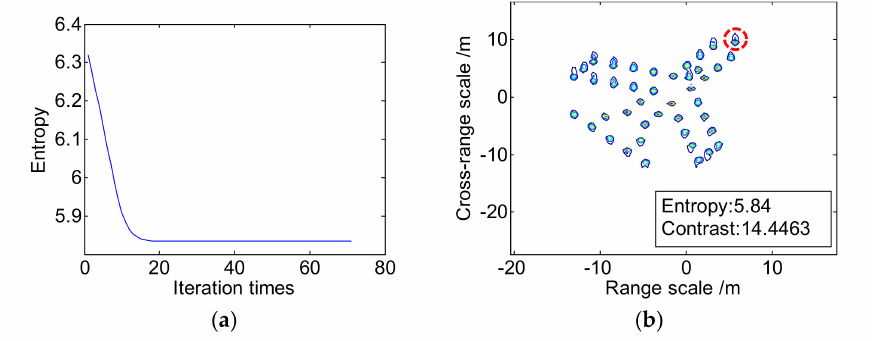
Figure 10. Search for optimal RAA and imaging result through gradient descent method. ( a ) Entropy of ISAR image during iteration; ( b ) output ISAR image.